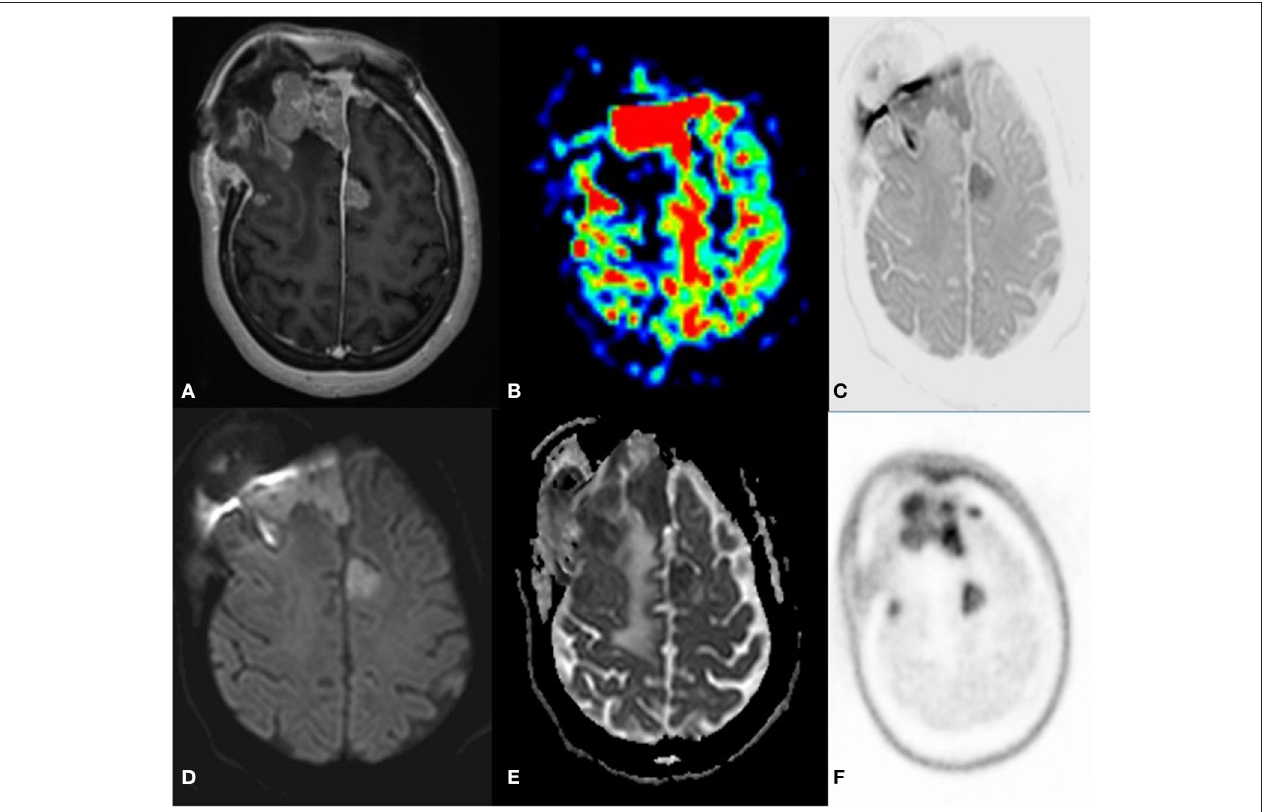
FIGURE 8 | A 33 year old female postoperative, post-radiotherapy case of Embryonal tumor compatible (atypical teratoid rhabdoid tumor) 1 year follow up MRI C-11 Methionine PET axial images post-contrast T1 (A) ASL (B) Inverted DWI (C) DWI b2000 (D) ADC (E) NAC PET (F) showed Multiple enhancing dural based lesions are seen in bilateral frontal convexity and anterior falx with elevated perfusion. The lesion shows DWI restriction with hypermetabolism on PET. There is a match on the inverted DWI image and the NAC PET image, which is suggestive of